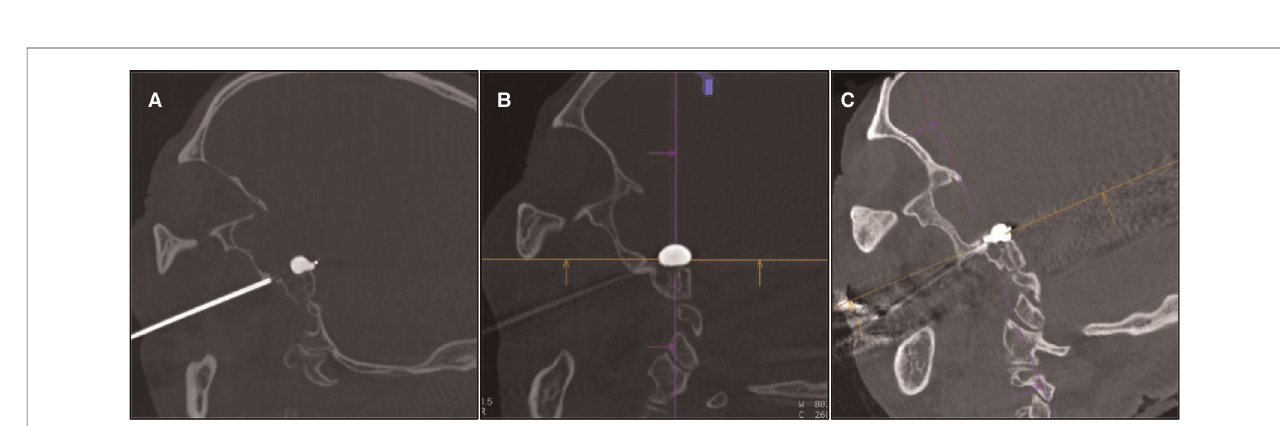
FIGURE 3 | Different balloon morphology ( A ) Pear shape. ( B ) Spherical. ( C ) Irregular shape.